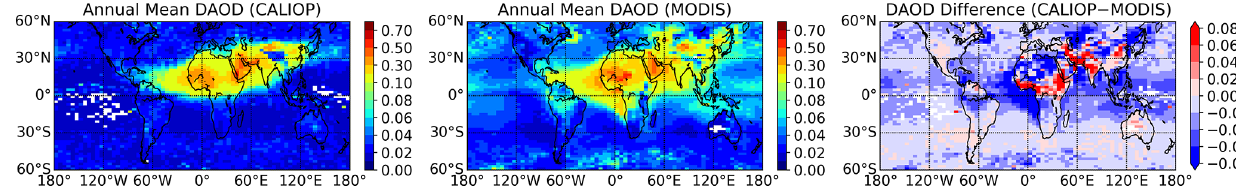
Figure 1. Global (60 ◦ S–60 ◦ N) spatial pattern of CALIOP-based and MODIS-based 4-year (2007–2010) mean DAOD (Song et al., 2021) and their difference.